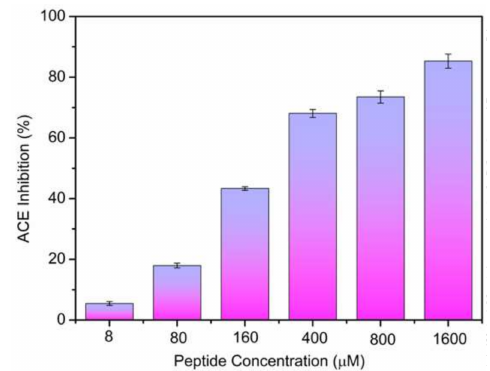
Figure 3. ACE-inhibitory activity of EPNGLLLPQY.